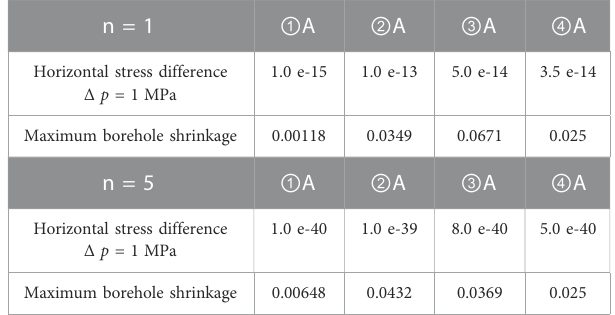
TABLE 5 The pre-coef fi cient A and the exponent n (Layer No. 3), in the case of n = 1 and